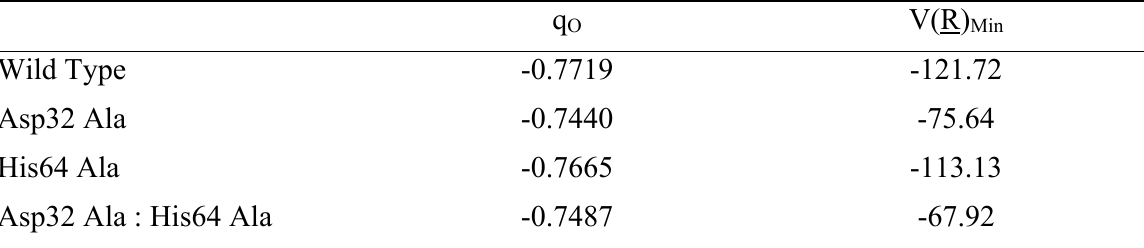
Table 4 : Serine oxygen charge (q kcalmol -1 ) calculated for the wild-type and mutant enzymes (3-21G Hartree Fock with ChelpG charges).